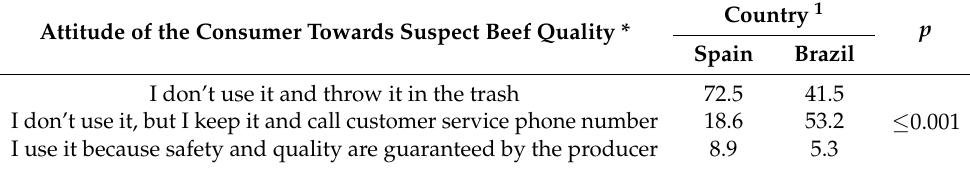
Table 9. Consumer behavior when beef is suspected of presenting a problem in terms of safety, quality and other